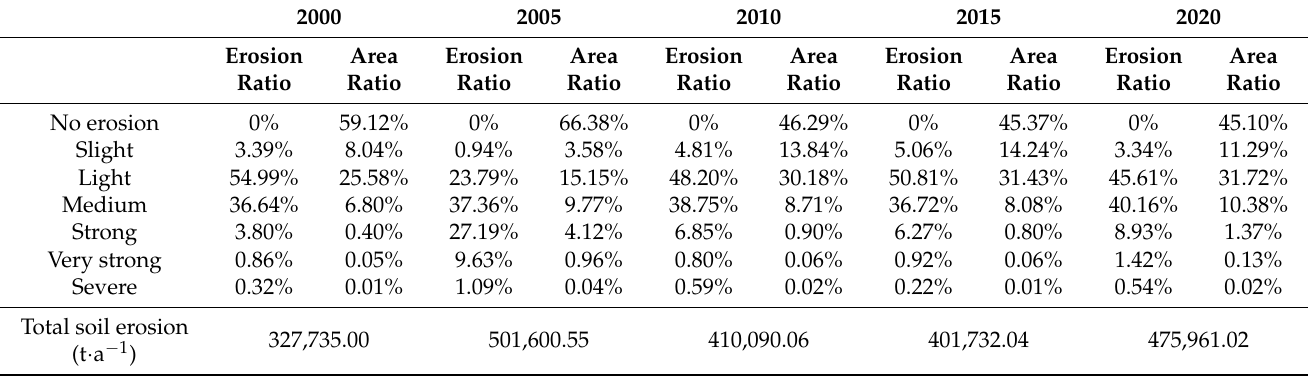
Table 3. The proportion of soil erosion characteristics.